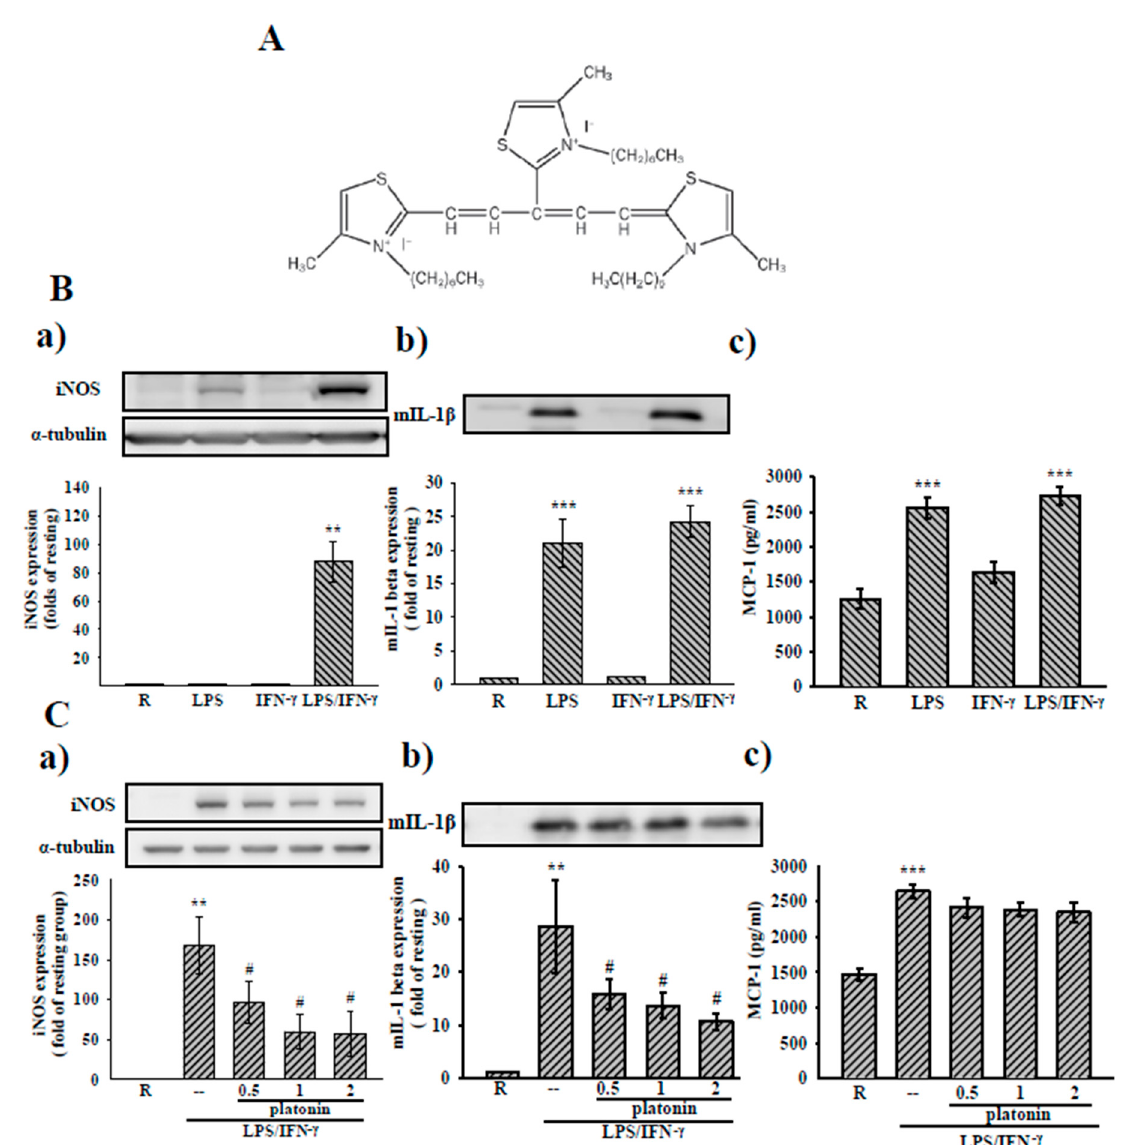
Figure 1. Effects of platonin on Lipopolysaccharides/Interferon gamma (LPS/IFN- γ )-induced inducible nitric oxide synthase (iNOS) expression, and production of mature Interleukin 1 β (IL-1 β ) (mIL-1 β ) and monocyte chemoattractant protein-1 (MCP-1) production in vascular smooth muscle cells (VSMCs). ( A ) The chemical structure of platonin. ( B , C ) VSMCs were pretreated without ( B ) or with ( C ) platonin (0.5–2 M) for 30 min and then stimulated with LPS, IFN- γ , or the combination of LPS (50 μ g/mL) and IFN- γ (100 units/mL, LPS/IFN- γ ) for 24 h. Western blotting assay was used to determine the cytosolic expression of iNOS and mIL-1 β content in the medium. MCP-1 production was determined using the ELISA kit described in “Materials and Methods.” Data are presented as mean ± structural equation modeling (S.E.M.) ( n = 3); ** p < 0.01, *** p < 0.001 compared to the resting (R) group; # P < 0.05 compared with the positive control group.